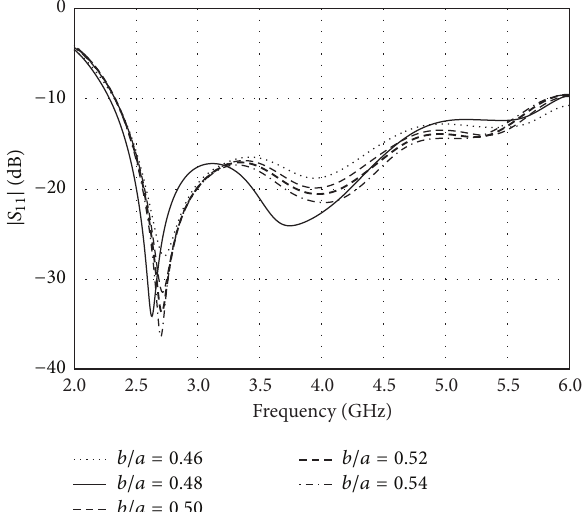
Figure 6: |𝑆 11 | relative to frequency as a function of 𝑟 𝑐 ( 𝛿 = 1.00